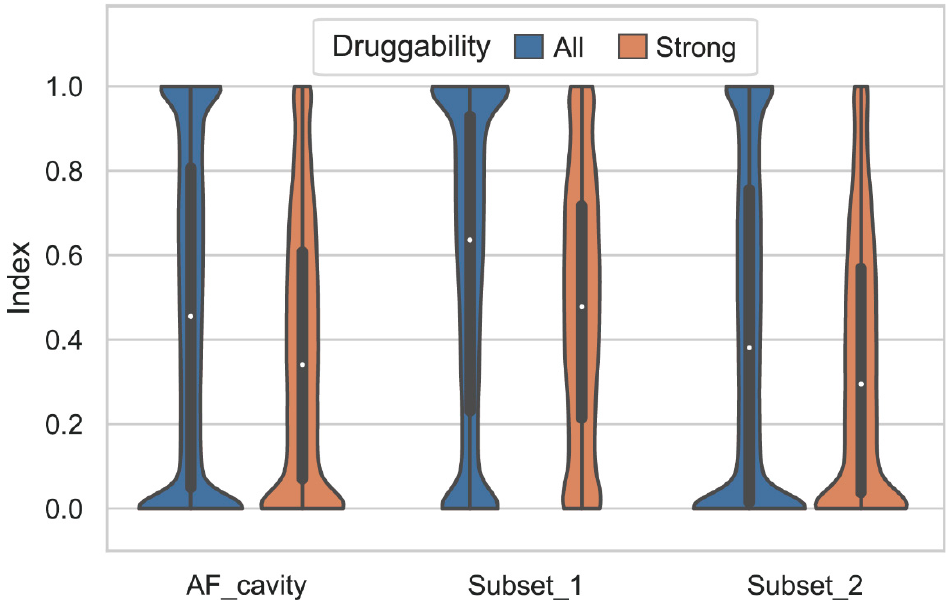
Figure 3. The distributions of Index that is the proportion of cavity residues with high confidence (pLDDT > 90). AF_cavity: cavities detected from AlphaFold predicted protein structures; Subset_1: cavities from proteins that have known 3D structures in our hrefPDB dataset; Subset_2: the remaining cavities after removing Subset_1 from AF_cavity. The distributions of all cavities (blue) and cavities with strong druggability (orange) in each dataset are displayed respectively.